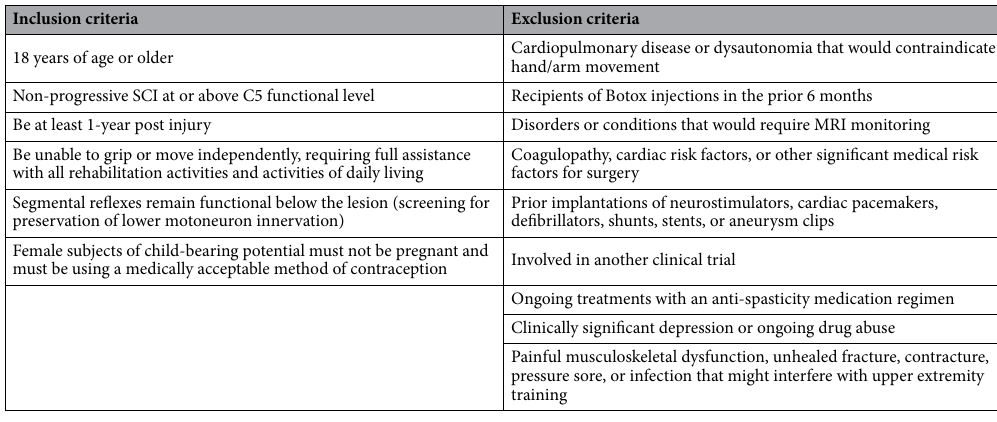
Table 3. All research participants, irrespective of age or sex, will meet the following criteria 10